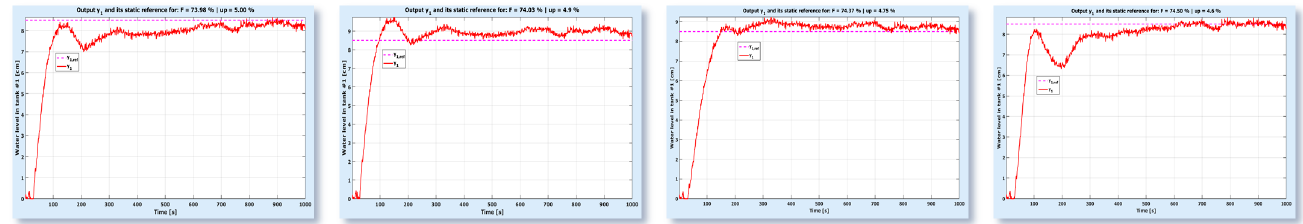
Figure 27. Output signals behavior around the robustness margin.